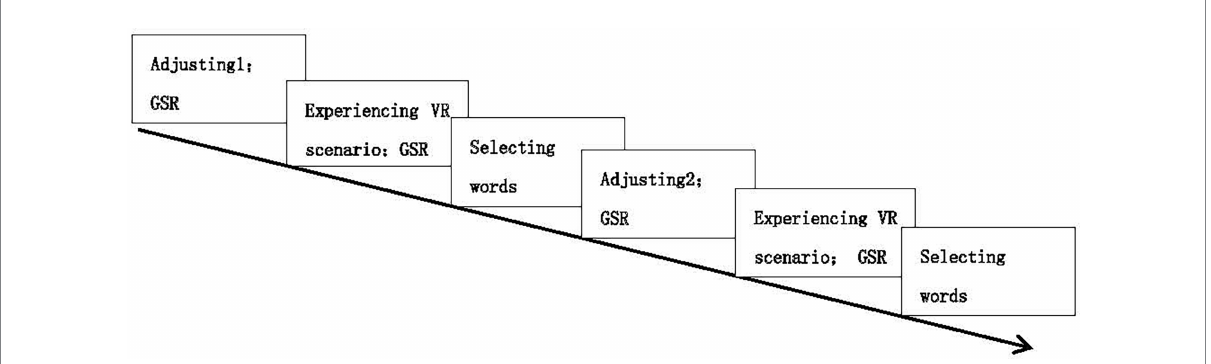
FIGURE 1 VR elevator experiment procedure. GSR, galvanic skin